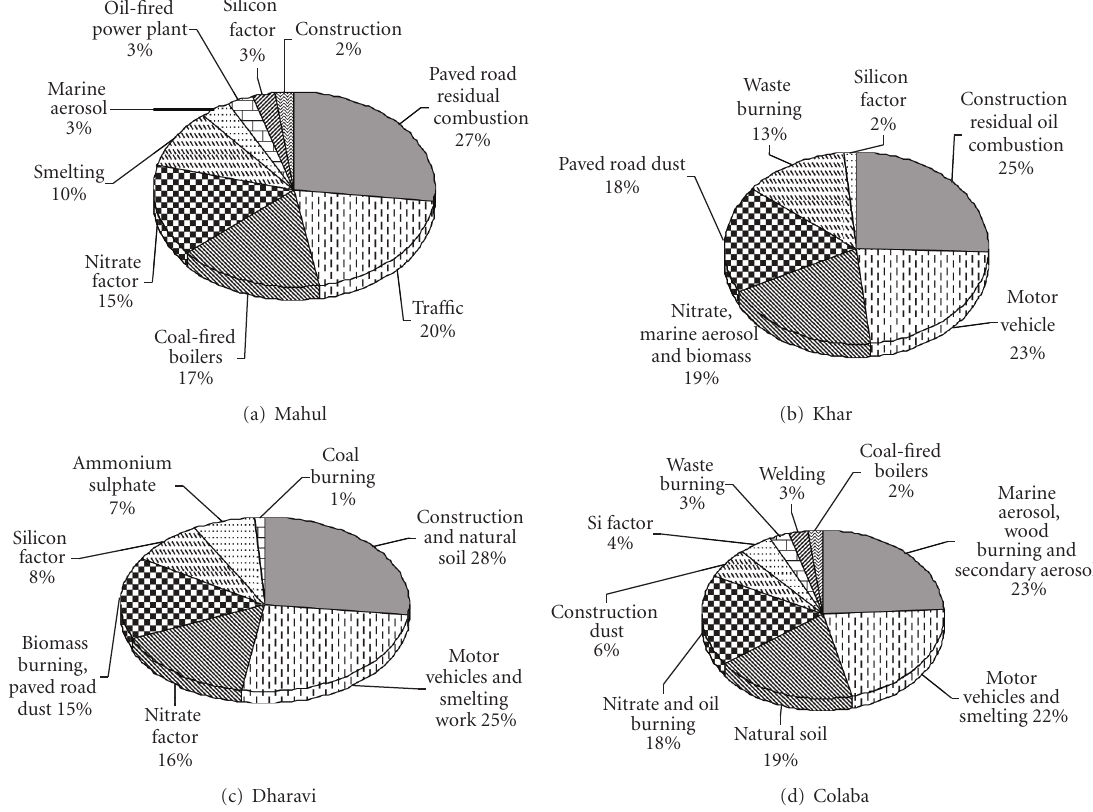
Figure 3: Source contribution from four monitoring